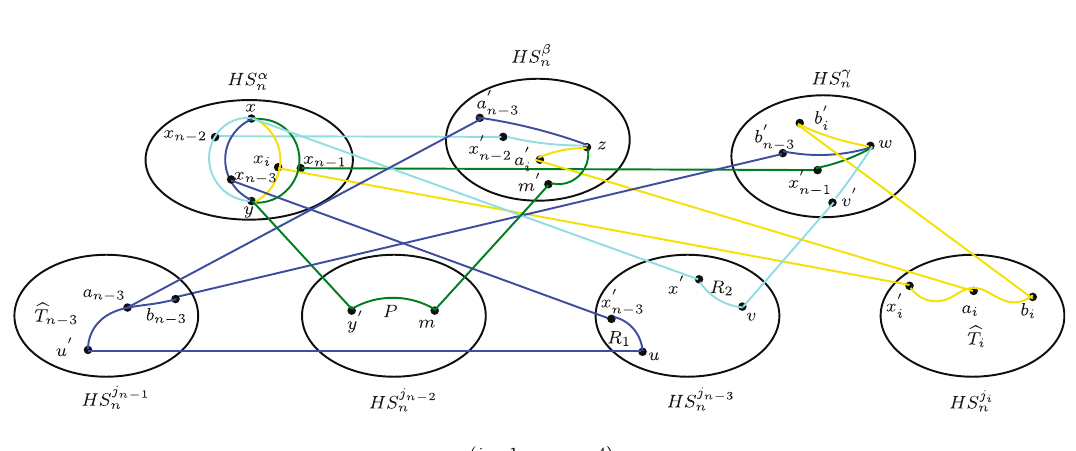
Figure 8: The illustration of